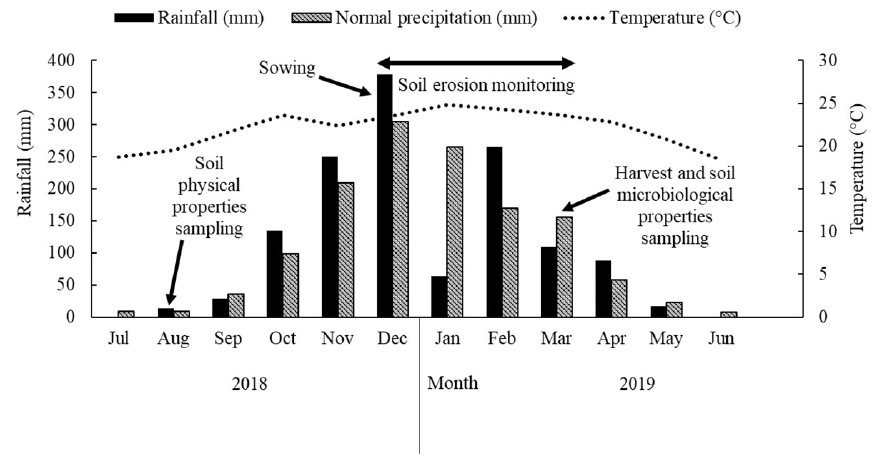
Figure 1. Daily average temperature and monthly precipitation data during the monitoring period (August 2018 to July 2019). The normal precipitation corresponds to the period from 1927 to 2013. Adapted from Silva et al. [16].